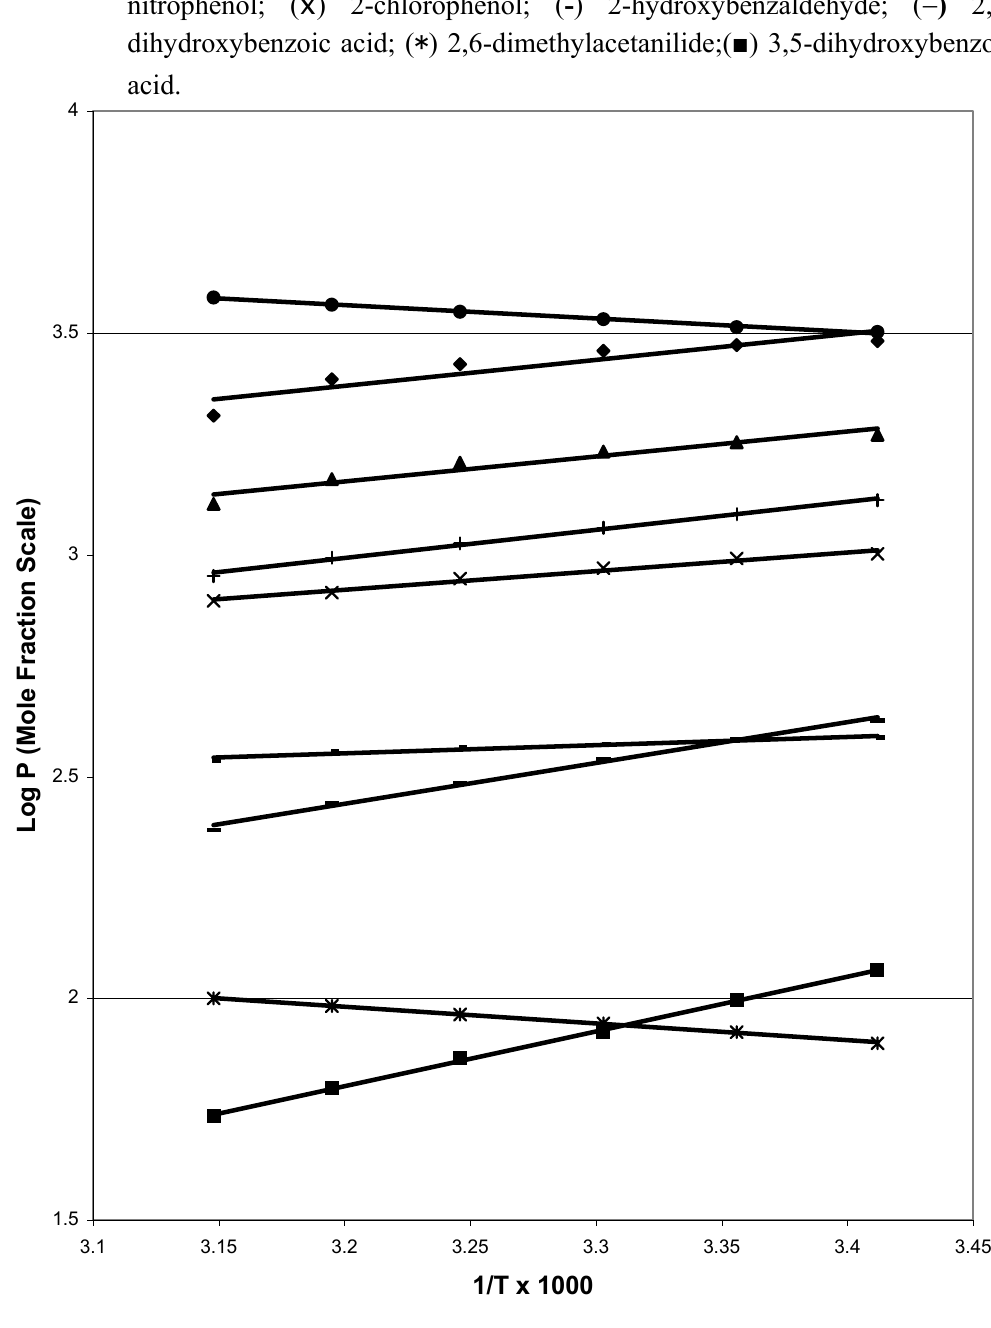
Figure 1. van’t Hoff plots for nine of the compounds used in this work: ( ● ) 6-methyl-2- nitrophenol; ( ∋ )2,3,6-trimethylphenol; ( ▲ ) 4-chlorophenol; (+) 3-methyl-2- nitrophenol; ( x ) 2-chlorophenol; ( - ) 2-hydroxybenzaldehyde; ( − ) 2,6- dihydroxybenzoic acid; ( * ) 2,6-dimethylacetanilide;( ■ ) 3,5-dihydroxybenzoic